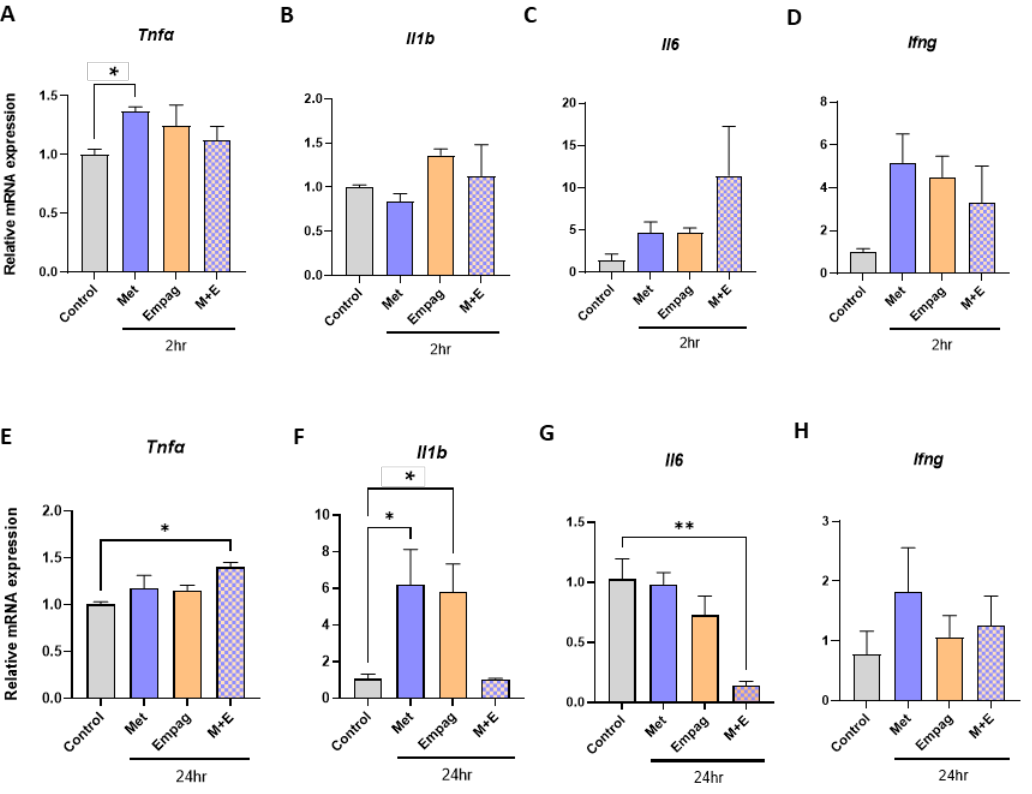
Figure 3. Metformin and empagliflozin in combination have contrasting effects on inflammatory gene expression in BMDM compared to single agents. ( A – D ) 2 h, 10 µ M, ( E – H ) 24 h, 10 µ M gene expression in BMDM compared to single agents. ( A – D ) 2 h, 10 μ M, ( E – H ) 24 h, 10 μ M (Met=Metformin, Empag = Empagliflozin, M+E = combination, n = 3 – 4 per group, one-way ANOVA, (Met = Metformin, Empag = Empagliflozin, M+E = combination, n = 3–4 per group, one-way data are mean ± SEM, * p ≤ 0.05, ** p ≤ 0.01 relative to control). ANOVA, data are mean ± SEM, * p ≤ 0.05, ** p ≤ 0.01 relative to